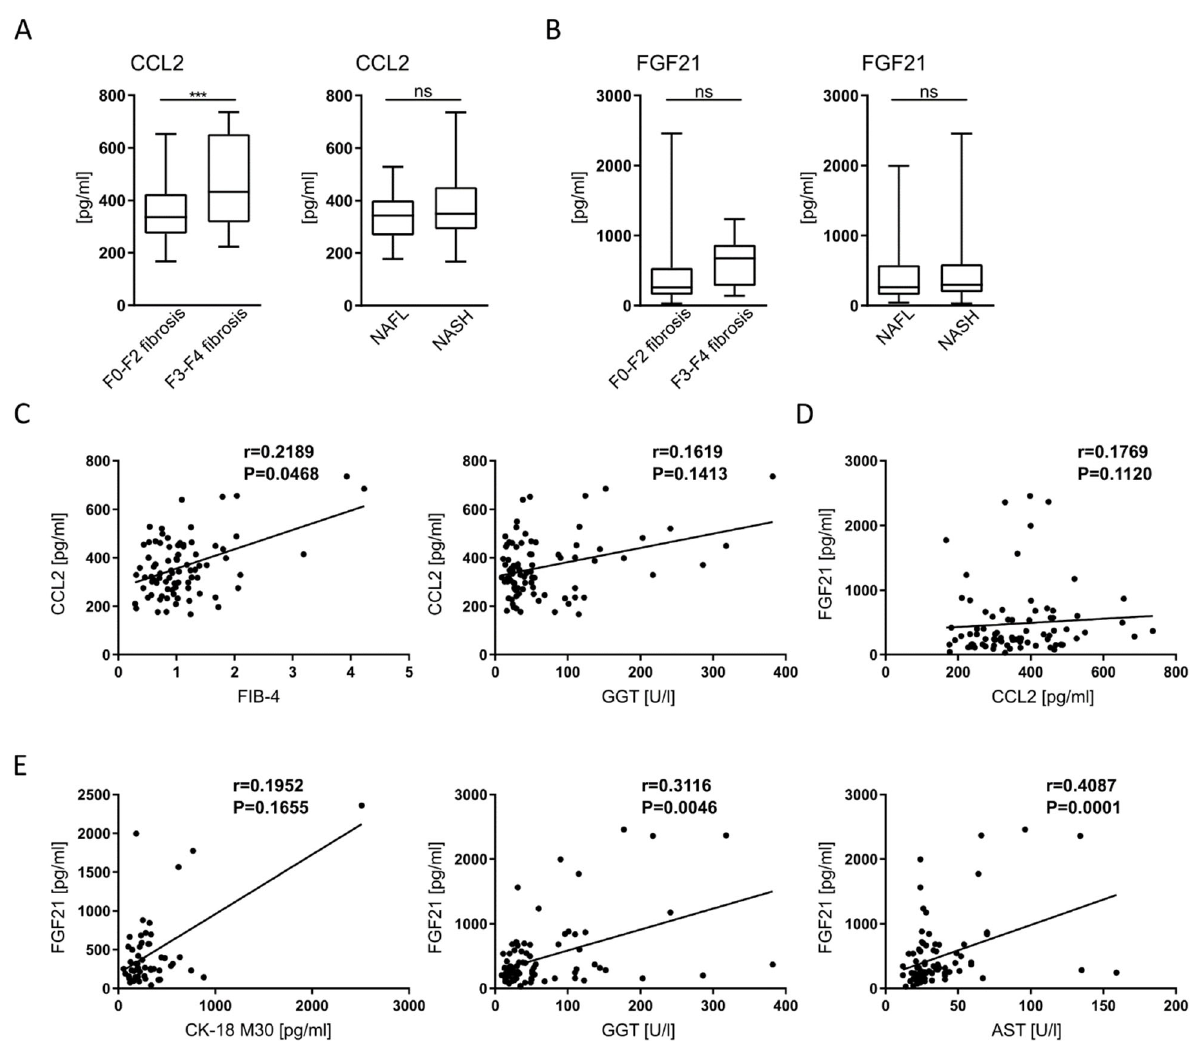
Figure 1. Correlation of CCL2 and FGF21 serum levels with severity of human NAFLD. Serum samples were obtained from patients with biopsy-proven NAFLD ( n = 85). ( A , B ) CCL2 and FGF-21 serum levels measured by ELISA and correlated with histologically assessed severity of liver fibrosis and steatohepatitis. ( C , D ) Correlation of CCL2 serum concentrations with biomarkers of fibrosis (FIB-4 and GGT) and FGF-21 serum levels. ( E ) Association of FGF-21 serum levels with biomarkers of steatohepatitis (CK-18 fragment M30, GGT and AST). ns = non-significant, *** p < 0.001 (unpaired Student t test in ( A , B ) Spearman’s r and p -values of linear correlation analysis in ( C – E )).